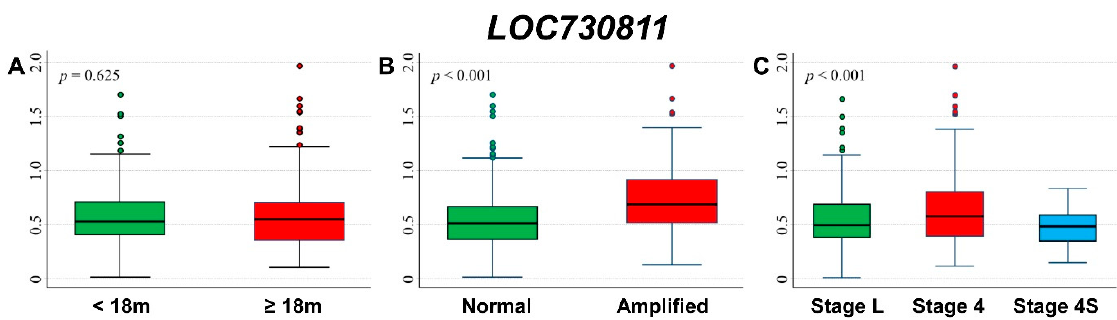
Figure 8. Association between LOC730811 expression and the main patient characteristics at diagnosis. ( A ) Age; ( B ) MYCN status; ( C ) Stage.